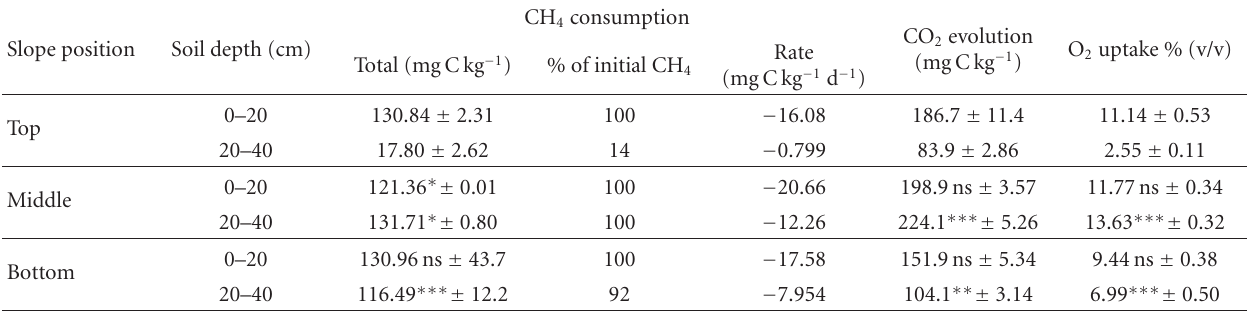
Table 3: CH 4 consumption, CO 2 evolution, and O 2 uptake in soils collected from three slope positions and incubated with 5kPa methane for 21 days (average values ± standard error, n = 3).